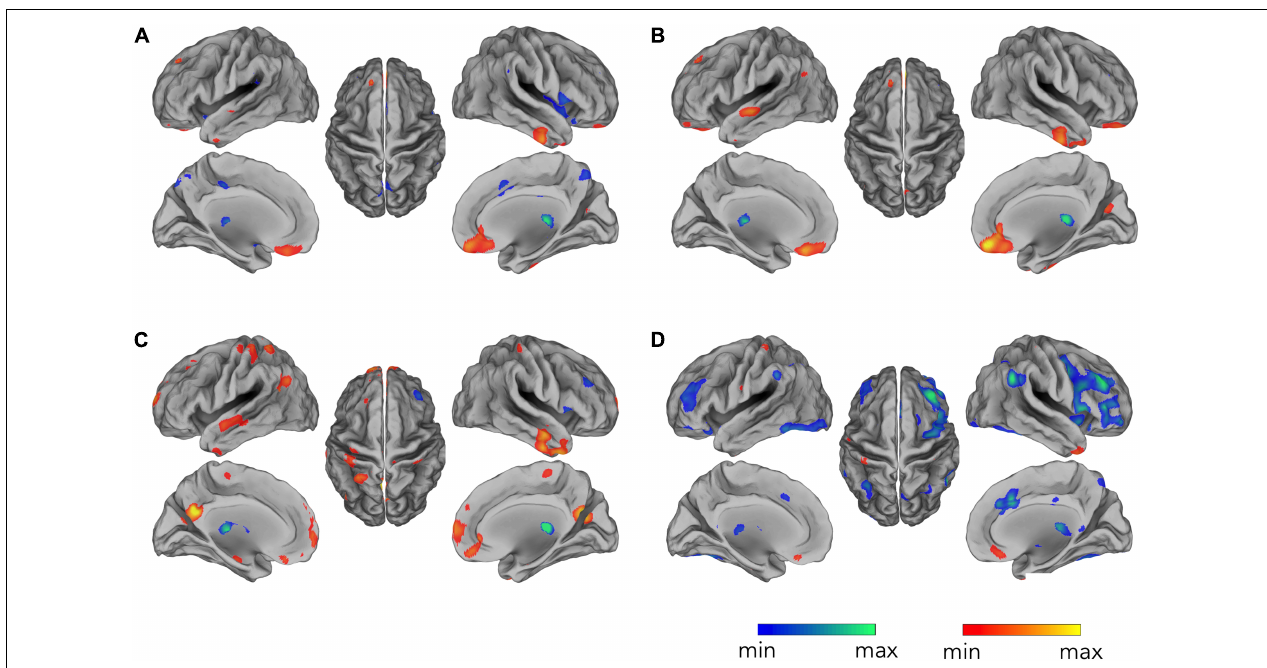
FIGURE 3 | Occipital EEG alpha power correlating with fMRI signals. Correlation maps are displayed for EEG data: (A) before gradient artifact correction, i.e., raw data, (B) after gradient artifact correction, (C) after BCG artifact correction, and (D) after ICA-based artifacts removal. Group-level correlation maps between occipital alpha power time-course and voxel-by-voxel fMRI signals ( n = 20, significance level p < 0.05 BY-FDR